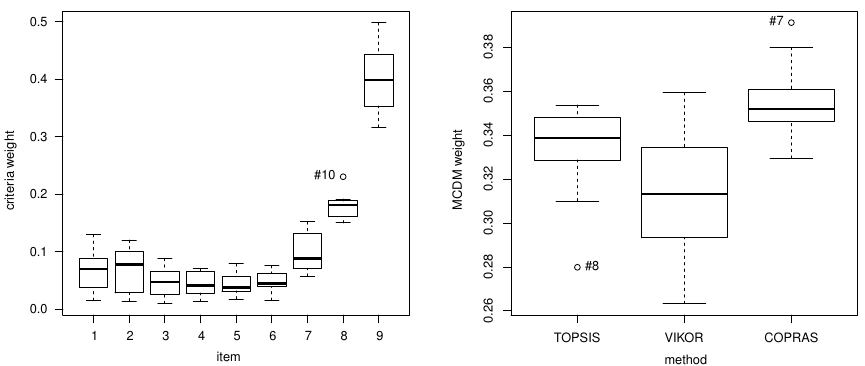
Figure 6. Boxplots of criteria weight for items ( first panel ) and MCDM weight ( second panel ) that form the MCDM RoCo SFSCM score (expressed as a proportion between zero and one) in the study.